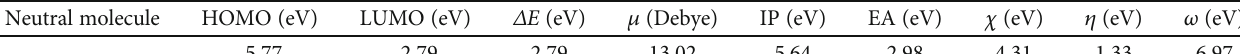
Table 5: The calculated quantum chemical descriptors for the metallic complex, SnX molecule, obtained using DFT at the B3LYP/LANL2DZ basis set in aqueous phase.